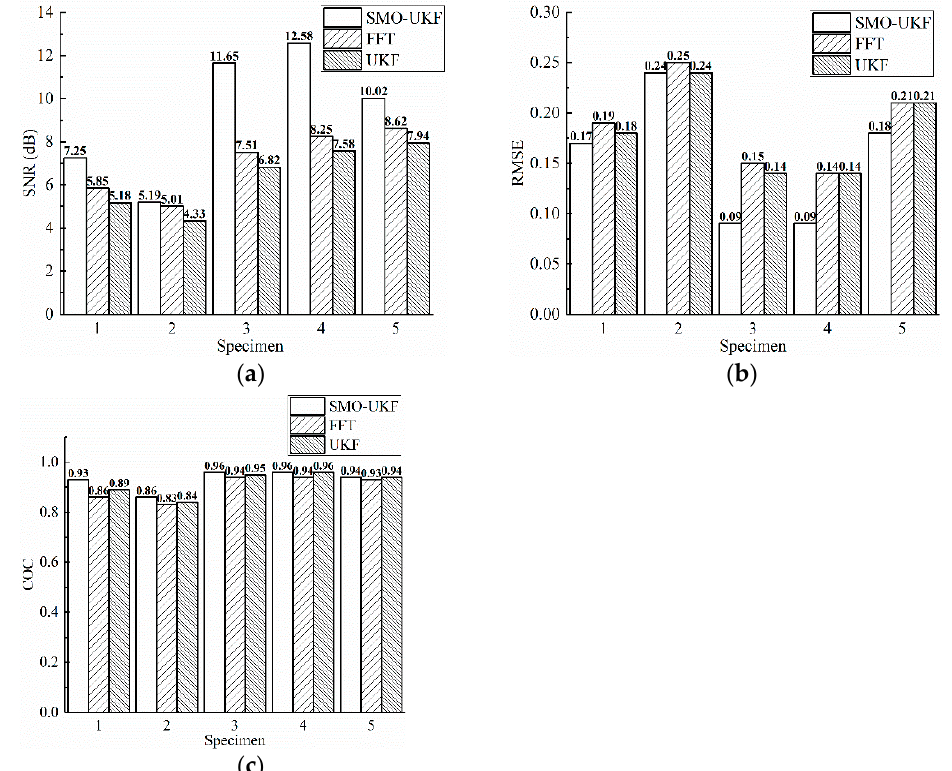
Figure 8. Denoising effect comparison between UKF, SMO–UKF and FFT: ( a ) SNR; ( b ) RMSE; ( c ) COC.